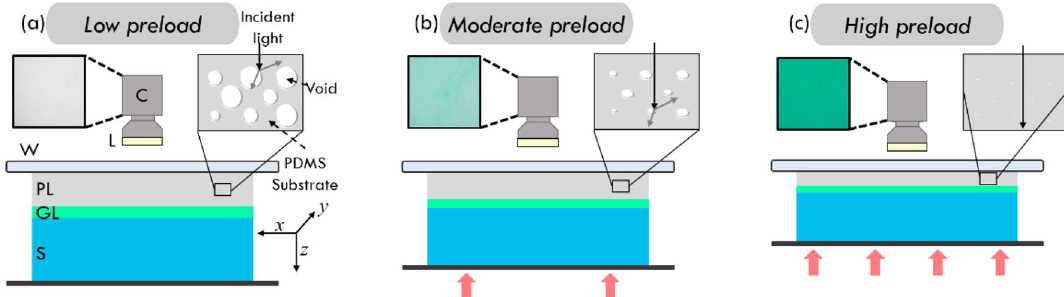
Figure 2. Working principle of CBOP. A CMOS camera is used to measure the transmission of light emitted by LEDs through the micro-porous layer and reflected back from the green layer under ( a ) low preloaded strain, ( b ) moderate preloaded strain and ( c ) high preloaded strain; C camera, L LEDs, W glass window, PL micro- porous layer, GL green layer, S sample. The insets from the camera show the change in green intensity with different preloaded strains. The micro-porous layer inset illustrates the reduction in pore size under increasing